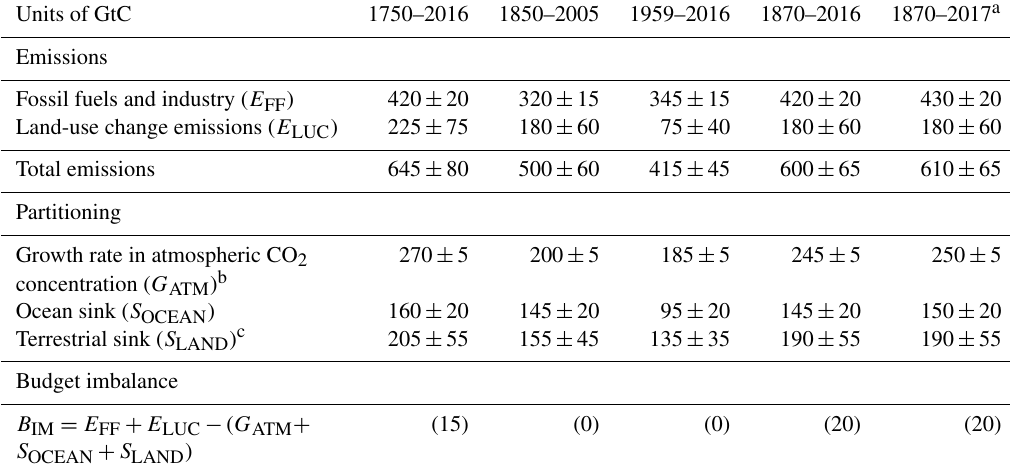
Table 8. Cumulative CO 2 for different time periods in gigatonnes of carbon (GtC). All uncertainties are reported as ± 1 σ . E LUC and S OCEAN have been revised to incorporate multiple estimates (Sect. 3.5), and, unlike previous versions of the global carbon budget, the terrestrial sink ( S LAND ) is now estimated independently from the mean of the DGVM. Therefore, the table also shows the budget imbalance, which provides a measure of the discrepancies among the nearly independent estimates. Its uncertainty exceeds ± 60GtC. The method used here does not capture the loss of additional sink capacity from reduced forest cover, which is about 15GtC and would exacerbate the budget imbalance (see Sect. 2.7.3). All values are rounded to the nearest 5GtC and therefore columns do not necessarily add to